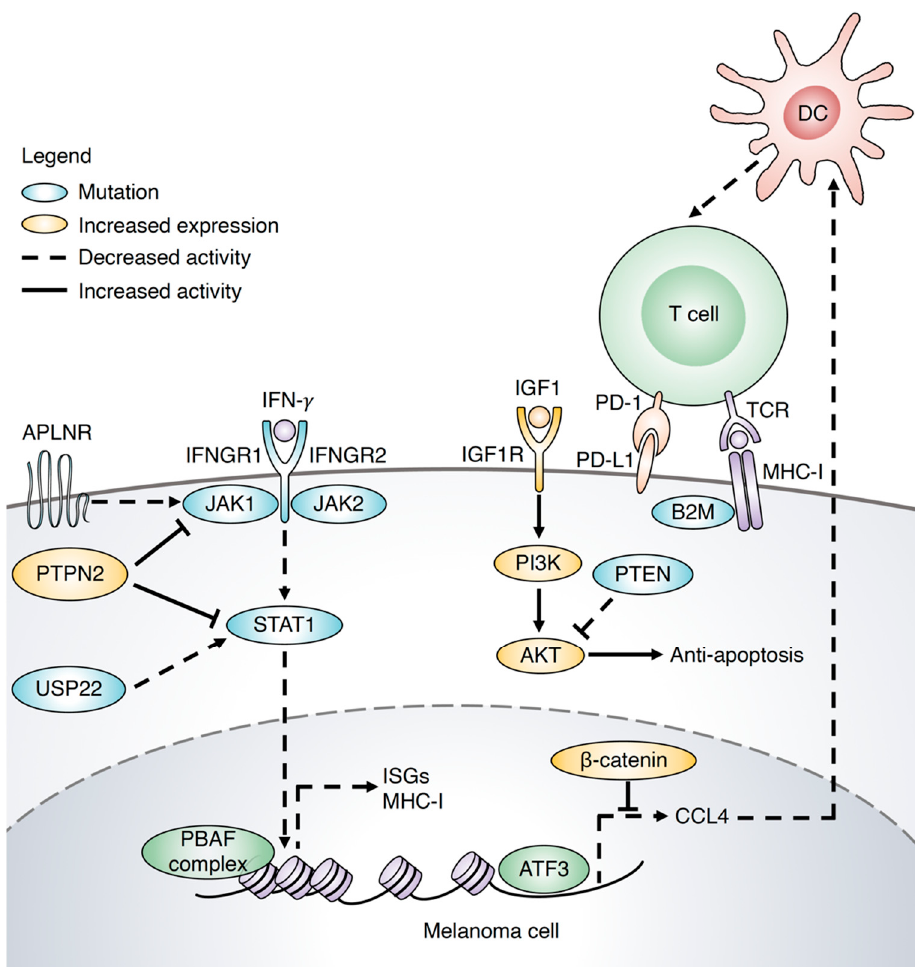
Figure 1 . Diverse mechanism supporting resistance to immunotherapy in melanoma. JAK-STAT is a major pathway involved in resistance to immune checkpoint inhibitors in melanoma. In the normal response, T cell-derived IFN- γ binds to its receptor on the tumor cells, IFNGR1/2, and then activates the JAK-STAT pathway to induce the transcription of downstream genes including ISGs and MHC-I. CCL4 is induced by the transcription factor ATF3 to activate DC, and PTEN regulates the activity of the PI3K/AKT pathway to induce apoptosis. Mutations in JAK1/2, IFNGR1 or regulators of the JAK-STAT pathway, including APLNR and USP22, or increases in the negative modulator of JAK-STAT pathway, PTPN2, cause the inactivation of the JAK-STAT pathway and resistance the transcription of ISGs [24]. Active β -catenin by the WNT/ β -catenin signaling suppresses CCL4 transcription from ATF3 leads to inactivation of DCs thereby reducing cytotoxic T cells [25].